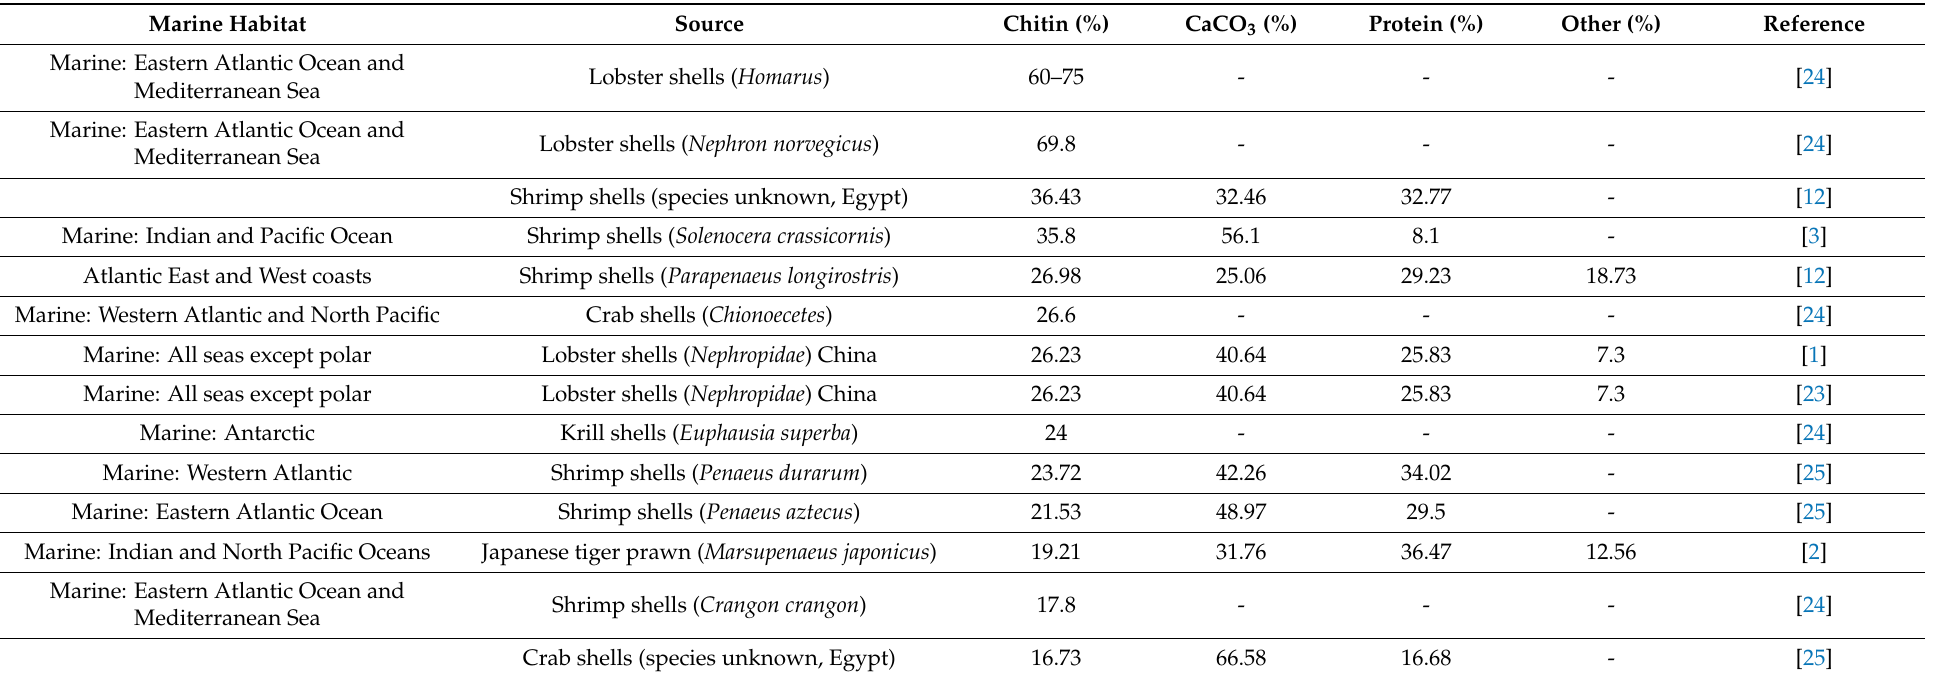
Table 2. The proportions of the constituents in a variety of marine crustacean shell